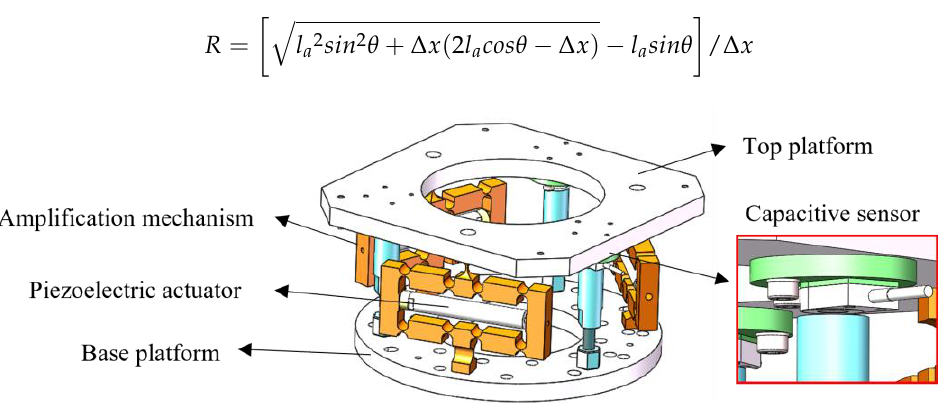
Figure 2. 3 − DOF piezoelectric positioning system.